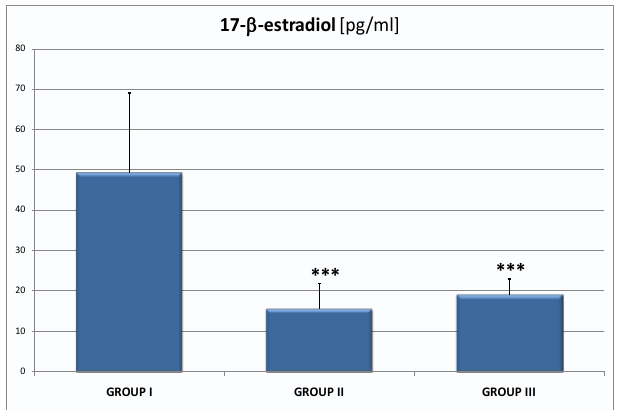
Figure 2. Urinary 6-sulphatoxymelatonin levels in group I 11.32 ± 4.42 µg/24 h, group II 9.08 ± 2.70 µg/24 h and III 8.36 ± 3.39 µg/24 h; they are the significant differences in mean value between group I and II; group I and III; * p < 0.05.